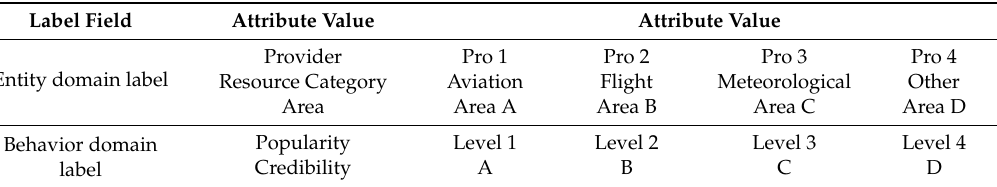
Table 1. An example of attribute label